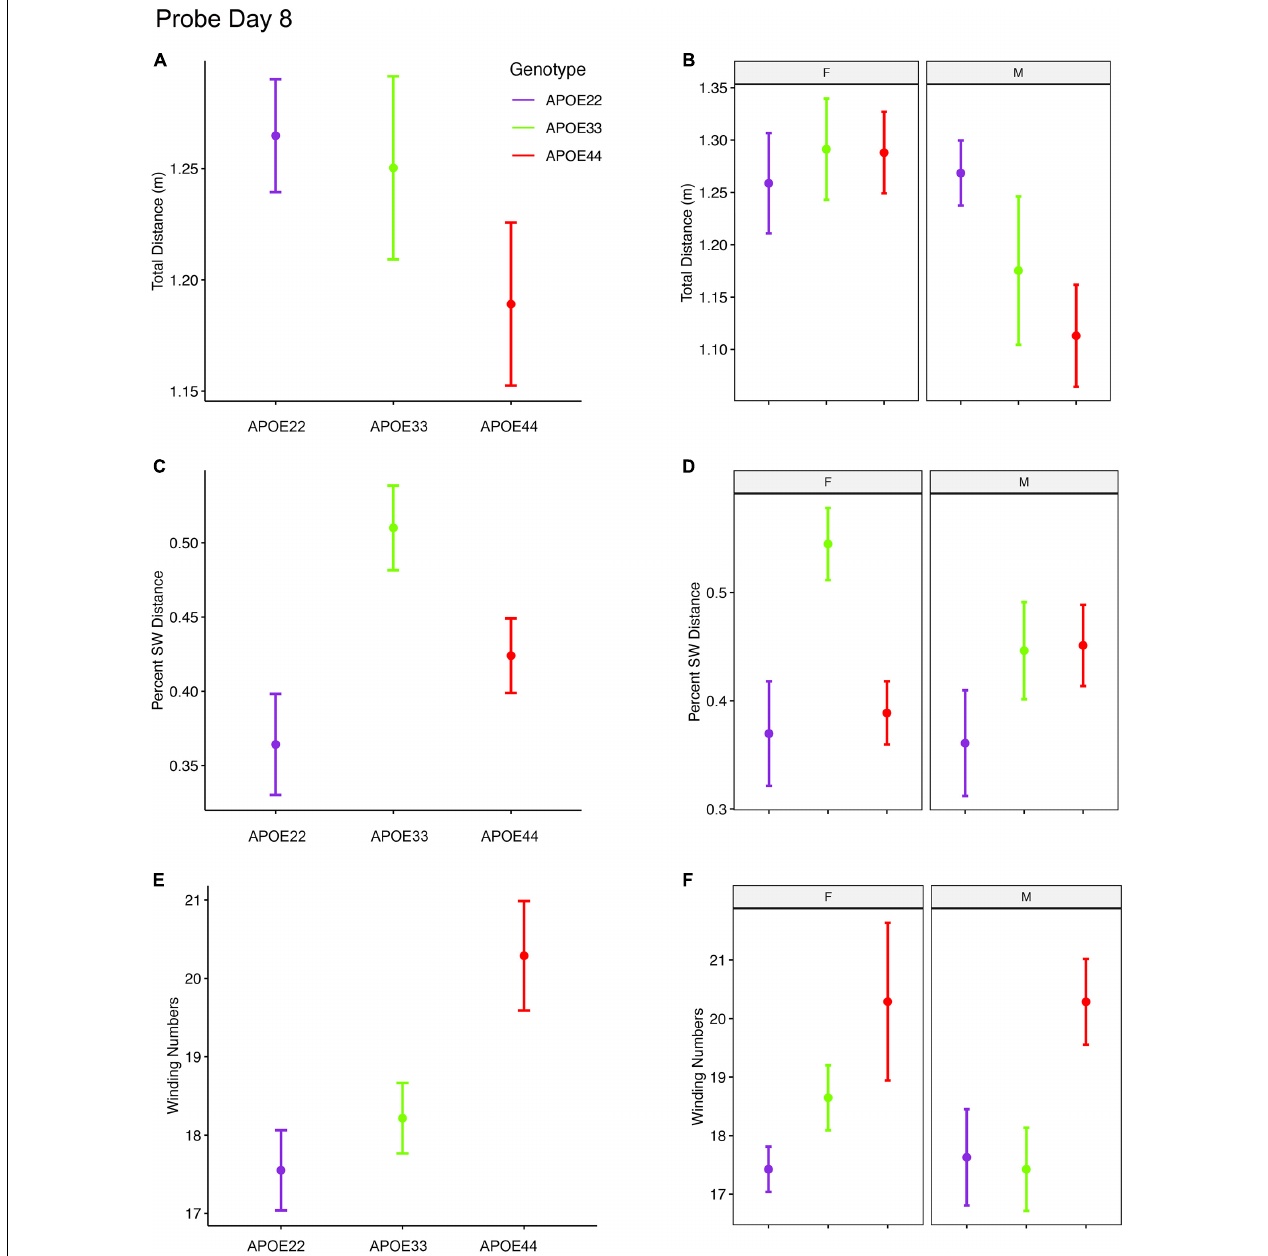
FIGURE 4 | Probe trials 3 days after ending the learning trials (mean ± standard error). (A) The largest effects in terms of total distance were seen in males, where APOE4 mice swam the shortest distances. Our analysis does not capture stops when animals may orient themselves (A,B) . (B) The percentage time swam in the target quadrant was largest in APOE3 mice relative to APOE2 and APOE4 mice (C,D) . This effect was driven largely by females, while male mice with APOE2 genotype spent less time in the target quadrant relative to other mice, and APOE3 and APOE4 mice performed similarly. A dose dependent effect was apparent in the absolute winding number for all genotypes, and this was reflected mostly in females. Male mice with APOE2 and APOE3 genotypes used similar strategies, females with APOE2 genotypes having smaller winding numbers (E,F) . APOE4 males had loopier swim trajectories relative to both APOE2 and APOE3 mice, which had similar trajectories. F, female; M, male. Graphs show mean ± standard error.